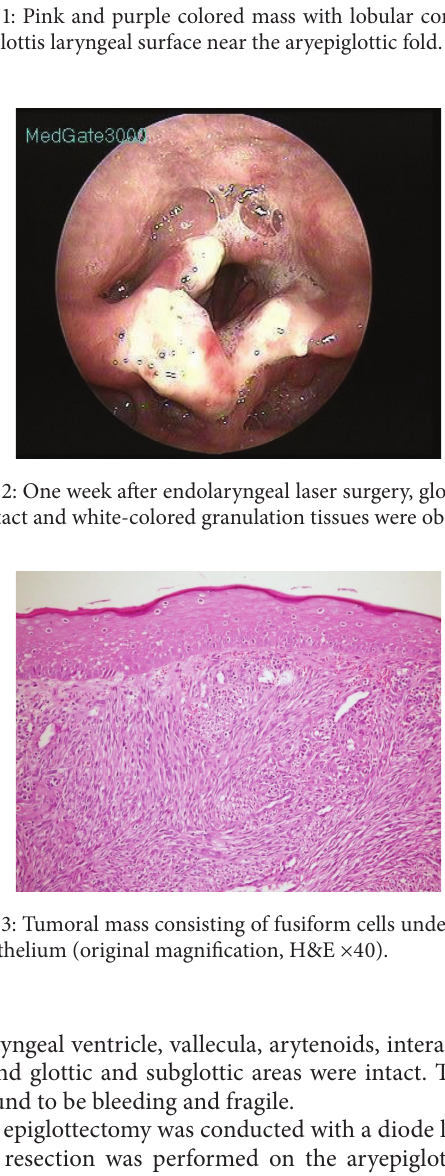
Figure 4: Some fusiform cells creating slits and bundle structures involving erythrocytes (original magnification, H&E × 100).